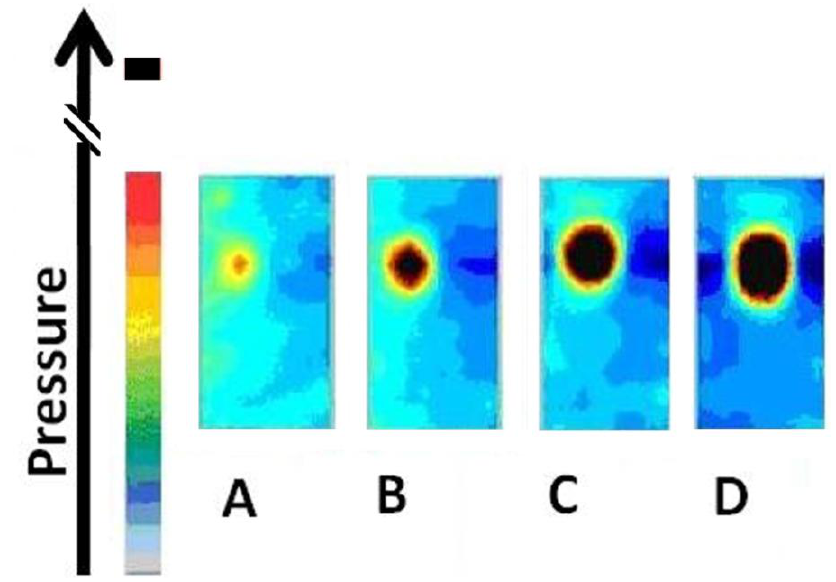
FIGURE 10. Comparative view of four graphic outputs (A–D) from testicular models with increasing rigidity. The color scale on the left shows the corresponding pressure measured as a reaction to predetermined deformation of the